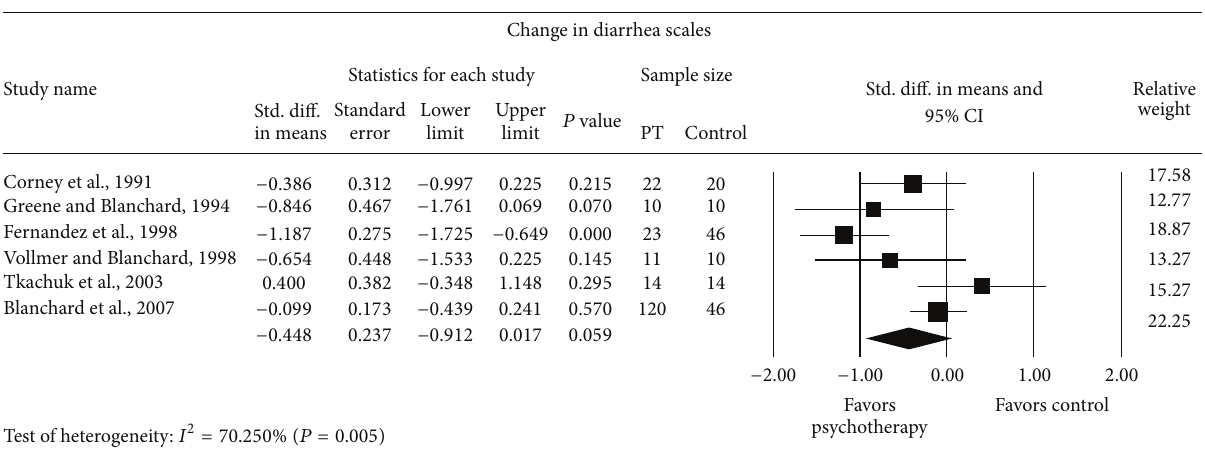
Figure 4: Forest plot for abdominal pain scales in RCTs of psychotherapy (PT) versus control.